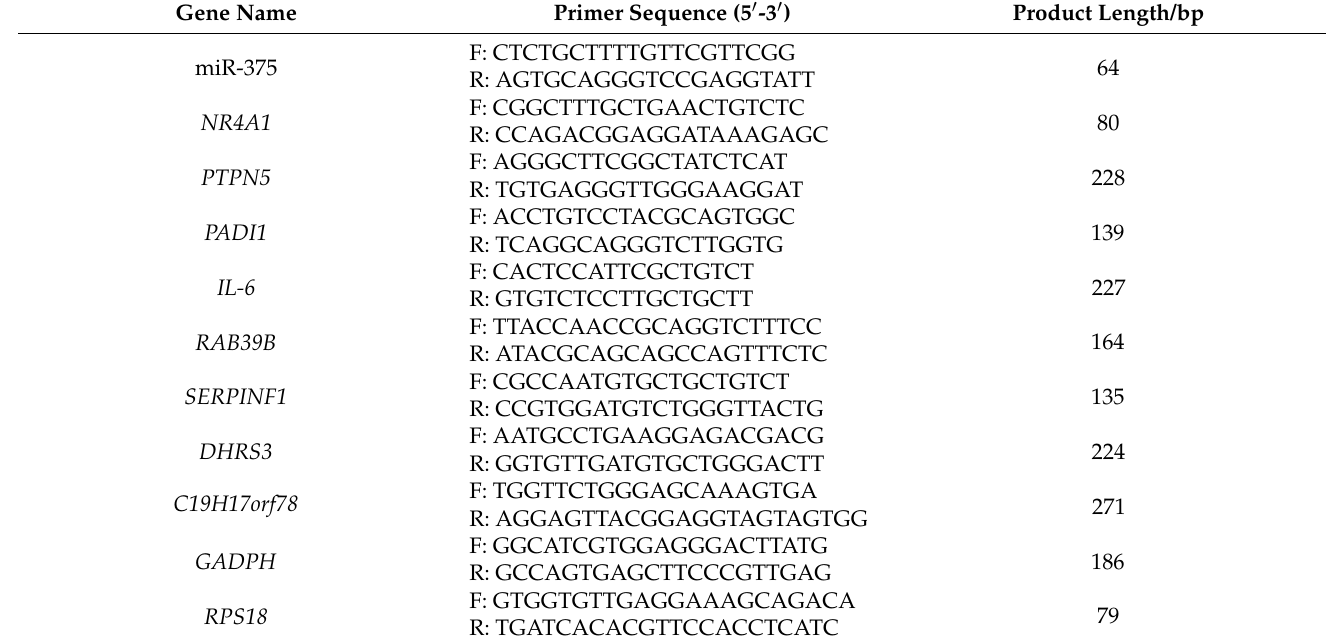
Table 1. qRT-PCR